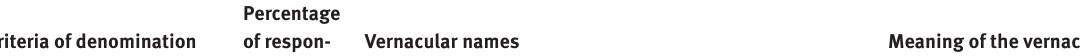
Criteria of denomination